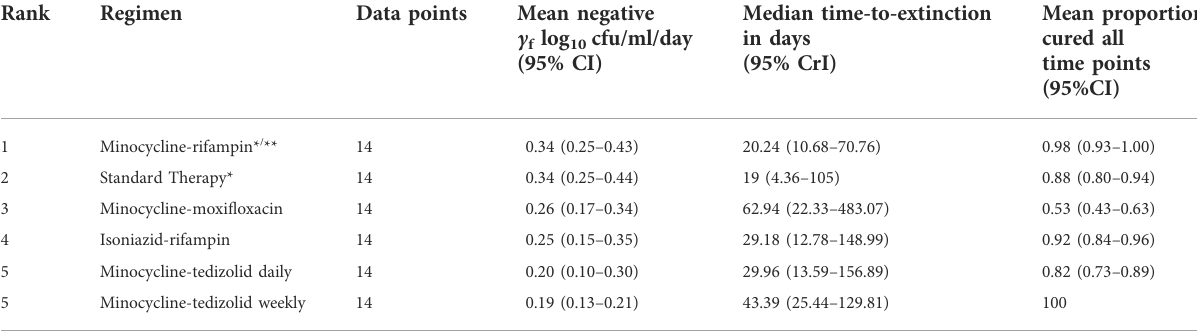
TABLE 3 ODE derived parameters of γ f and time-to-extinction in the HFS-TB, and proportion of patients expected to be